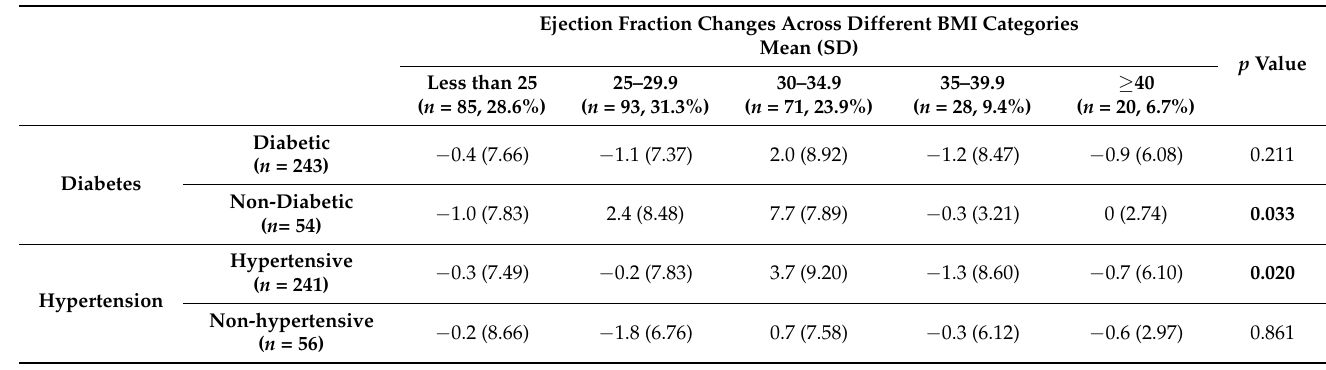
Table 3. Effect of diabetes and hypertension on ejection fraction among different BMI